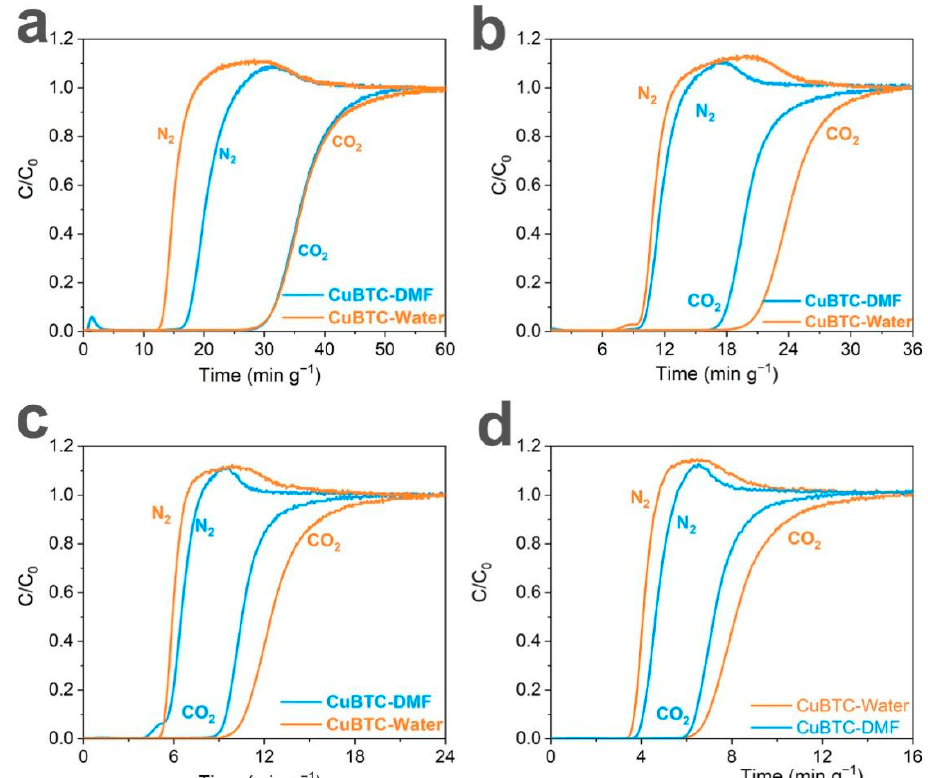
Figure 4. The dynamic breakthrough curves of CuBTC-DMF and CuBTC-Water for the CO 2 /N 2 mixture (The feed gas for the breakthrough measurement and chromatographic separation was composed of 20% CO 2 , 20% N 2 and 60% He.) at room temperature with different mass flow rates of ( a ) 10 sccm, ( b ) 20 sccm, ( c ) 50 sccm and ( d ) 100 sccm.